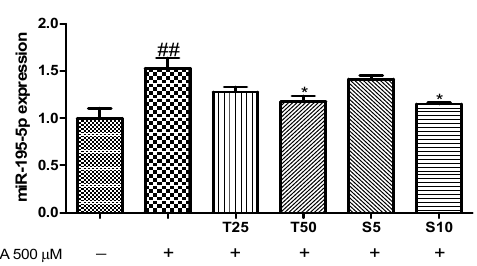
Figure 4. Effects of taxifolin and sorghum ethanol extract on the miR-195 expression in HepG2 cells. Data are presented as the mean ± standard error (n = 3). ## p < 0.01 versus the control cells. * p < 0.05 versus the FFA-treated group. FFA, free fatty acid; T, taxifolin ( µ M); S, sorghum ethanol extract ( µ g/mL).